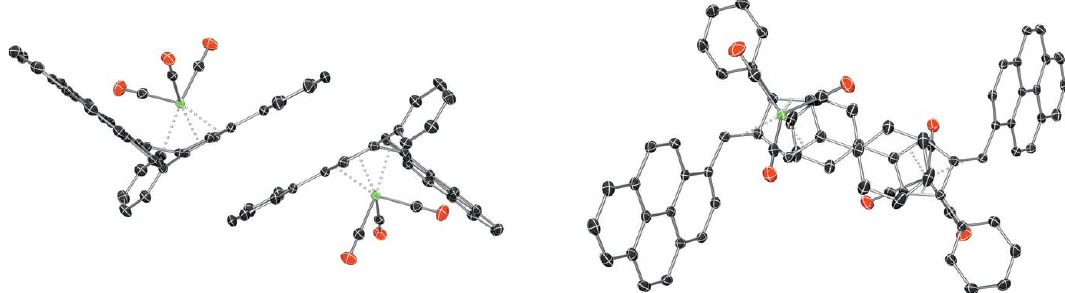
Figure 5 The (cid:2) – (cid:2) stacking arrangement of III , viewed in the plane (left) and normal to the place (right) of the cyclopentadiene-phenyl rings. Displacement ellipsoids are shown at the 50% probability level. Hydrogen atoms have been omitted for